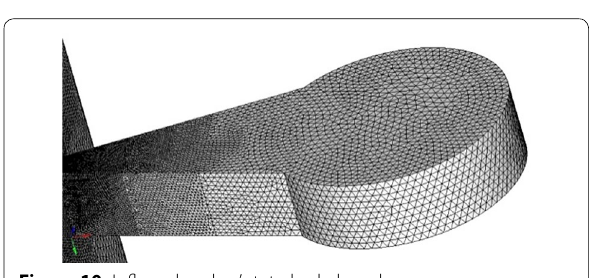
Figure 10 Inflow chamber’s tetrahedral